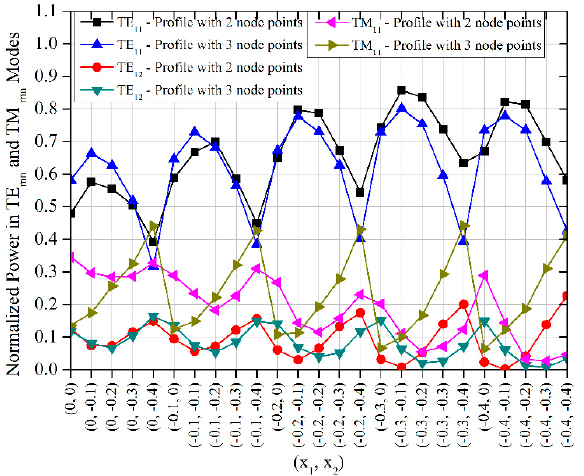
Figure 9. Normalized power in TEmn and TMmn modes for different values of x 1 and x 2 .